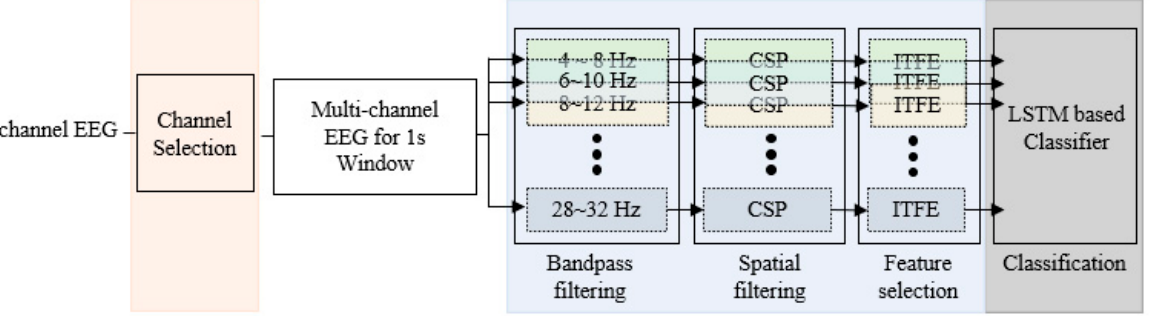
Figure 3. Processing steps of the FBCSP with channel